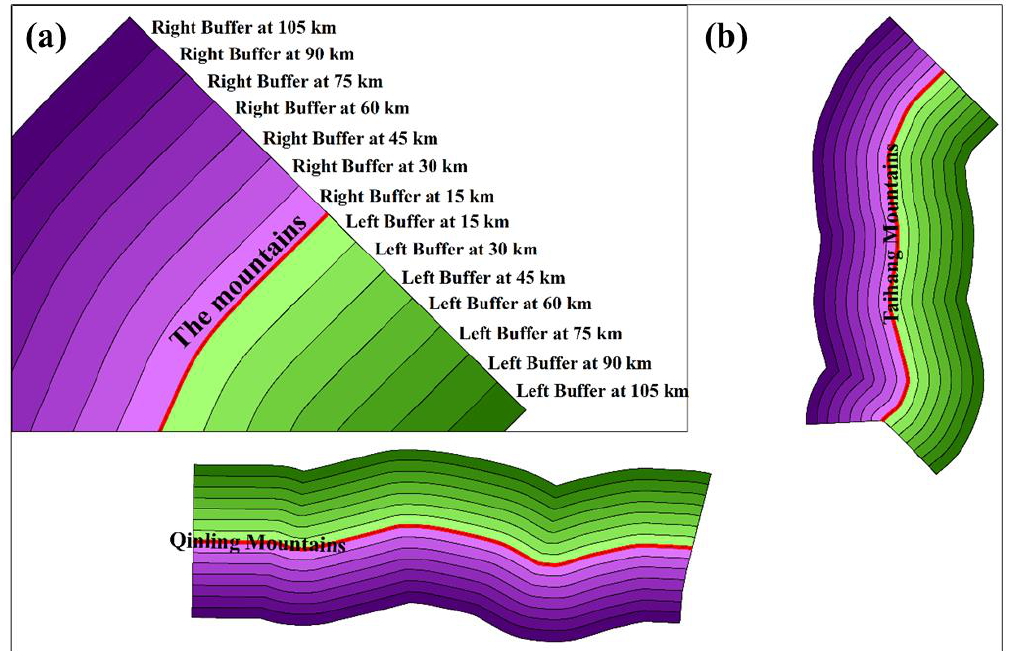
Figure A2. The schematic diagram for different buffer zones on the left and right side of the moun- tains ( a ). The purple buffer zones are the right buffers with radii of 15, 30, . . . , 105 km, and the green buffer zones are the left buffers with radii of 15, 30, . . . , 105 km. Two examples are provided in ( b ), one is the horizontally located mountains of the Qinling Mountains, the other is the vertically lo- cated mountains of the Taihang Mountains.